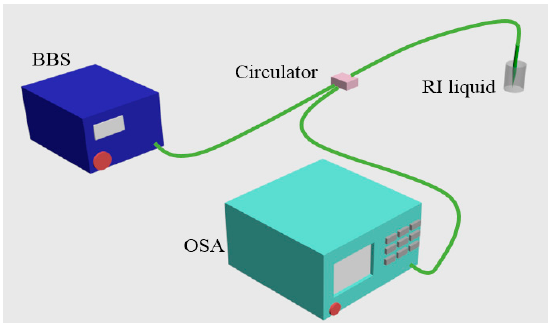
Figure 21. Experimental setup for RI sensing measurement.